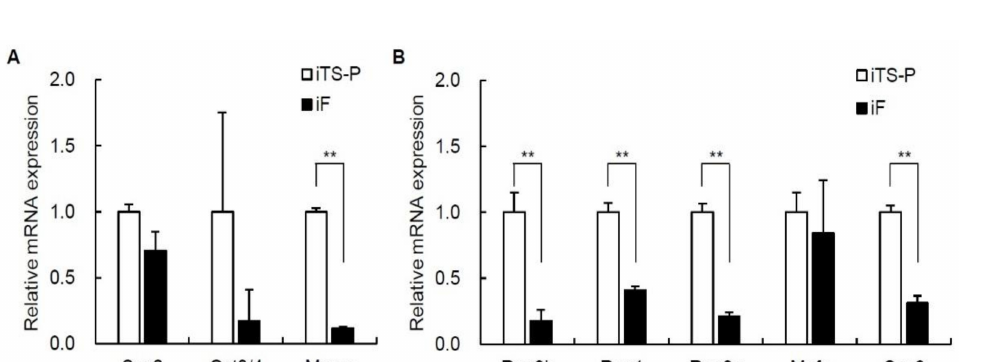
Figure 3. Quantitative reverse transcription-polymerase chain reaction (qRT-PCR) analysis of ES cell markers and endo- derm/pancreatic markers in iF cells (passage 30) and iTS-P cells (passage 30). ( A ) iTS-P cells and iF cells were evaluated for ES cell markers using qRT-PCR. ( B ) iTS-P cells and iF cells were evaluated for endodermal/pancreatic markers using qRT-PCR. The data are expressed as the gene-to-Gapdh ratio, with this ratio for iTS-P cells arbitrarily set to 1 ( n = 3). The error bars indicate the standard error values. ** p <